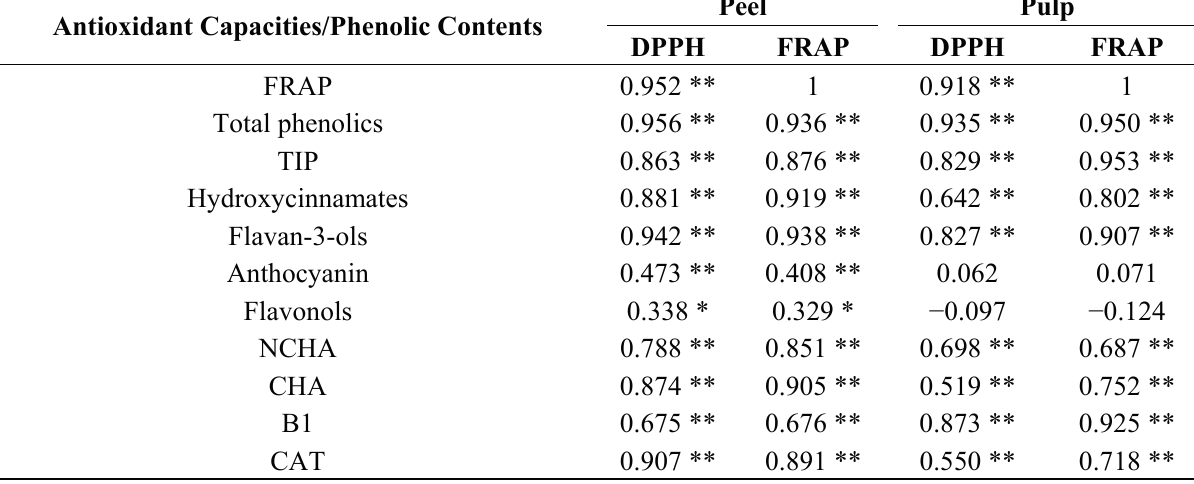
Table 6. Pearson’s correlation coefficients between antioxidant activities and phenolic